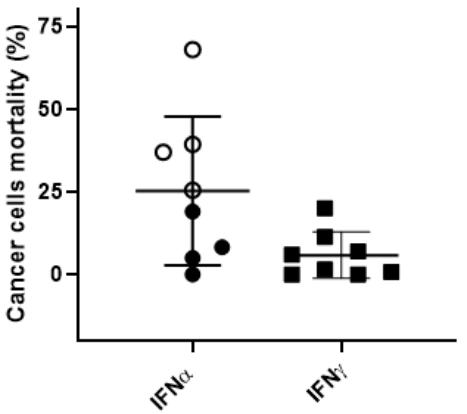
Figure 6. Sensitivity of wtGISTc to IFN α and IFN γ . After treatment, all wtGISTc resulted resistant to IFN γ and 4 out of 8 wtGISTc were relatively sensitive to IFN α (mean tumor cell death